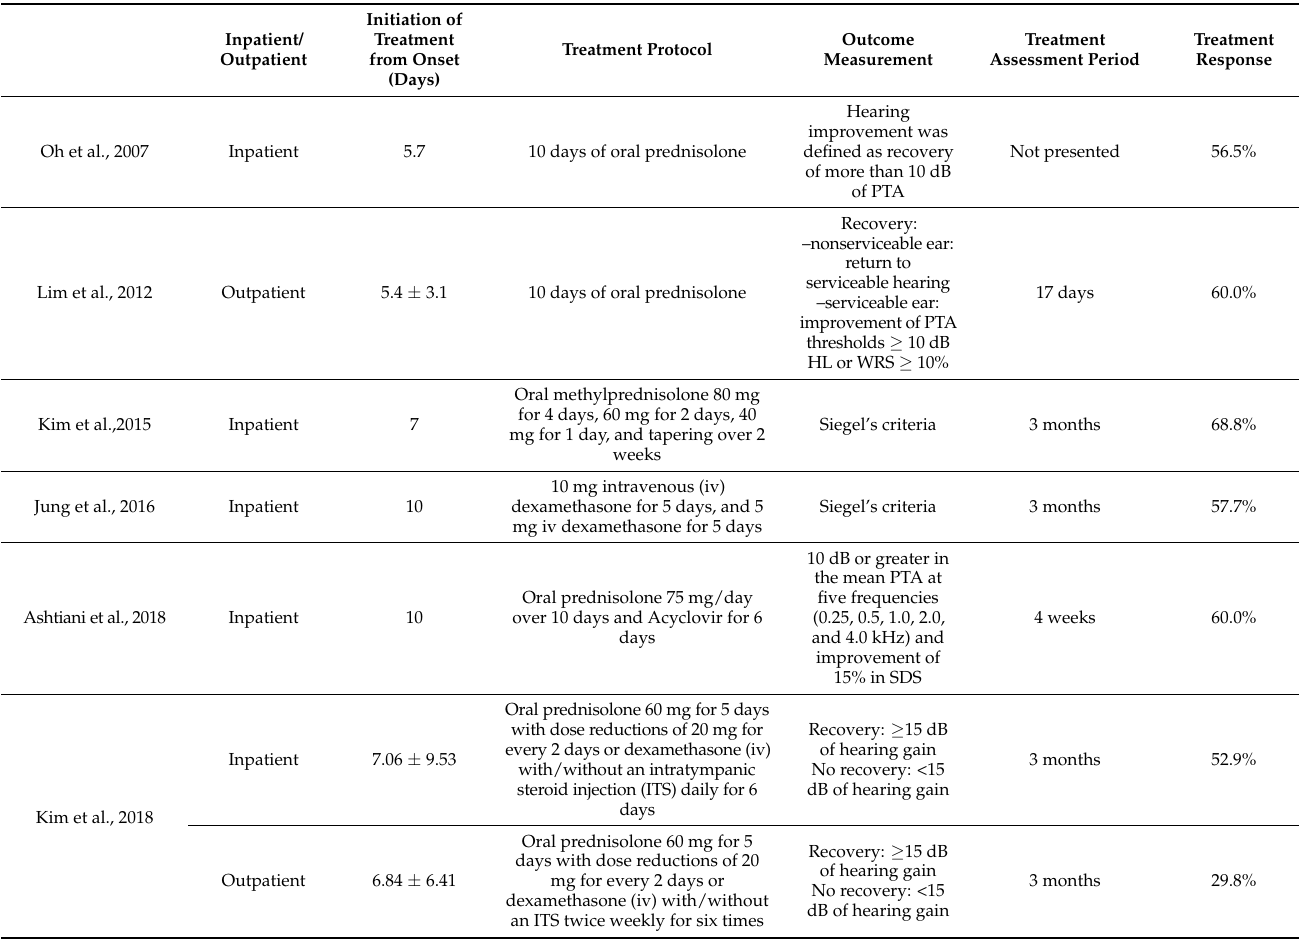
Table 4. Literature search results related to inpatient or outpatient-based treatment in sudden sensorineural hearing